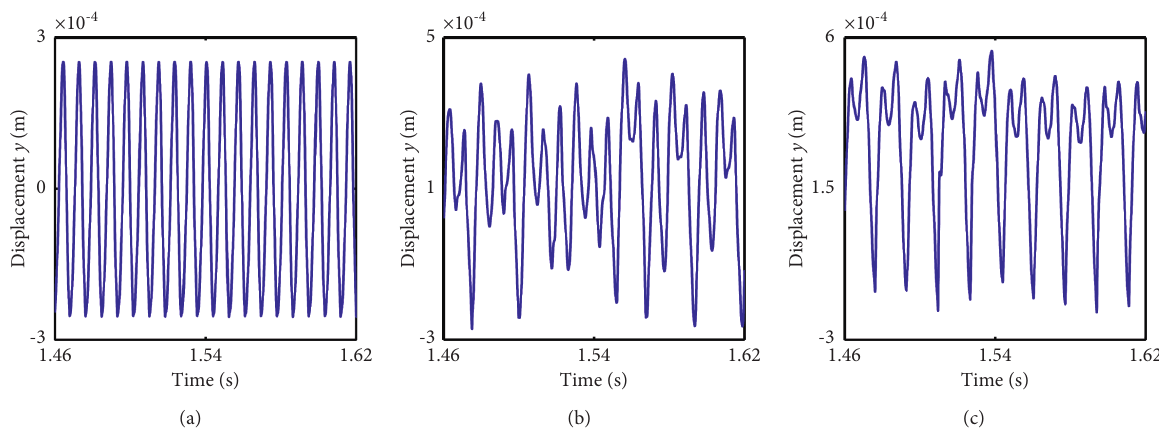
Figure 12: Vibration waveforms of the right journal with the change of the unbalance of two discs. (a) e � 0.1 × 10 –3 m, (b) e � 0.3 × 10 –3 m, and (c) e � 0.9 × 10 –3 m.